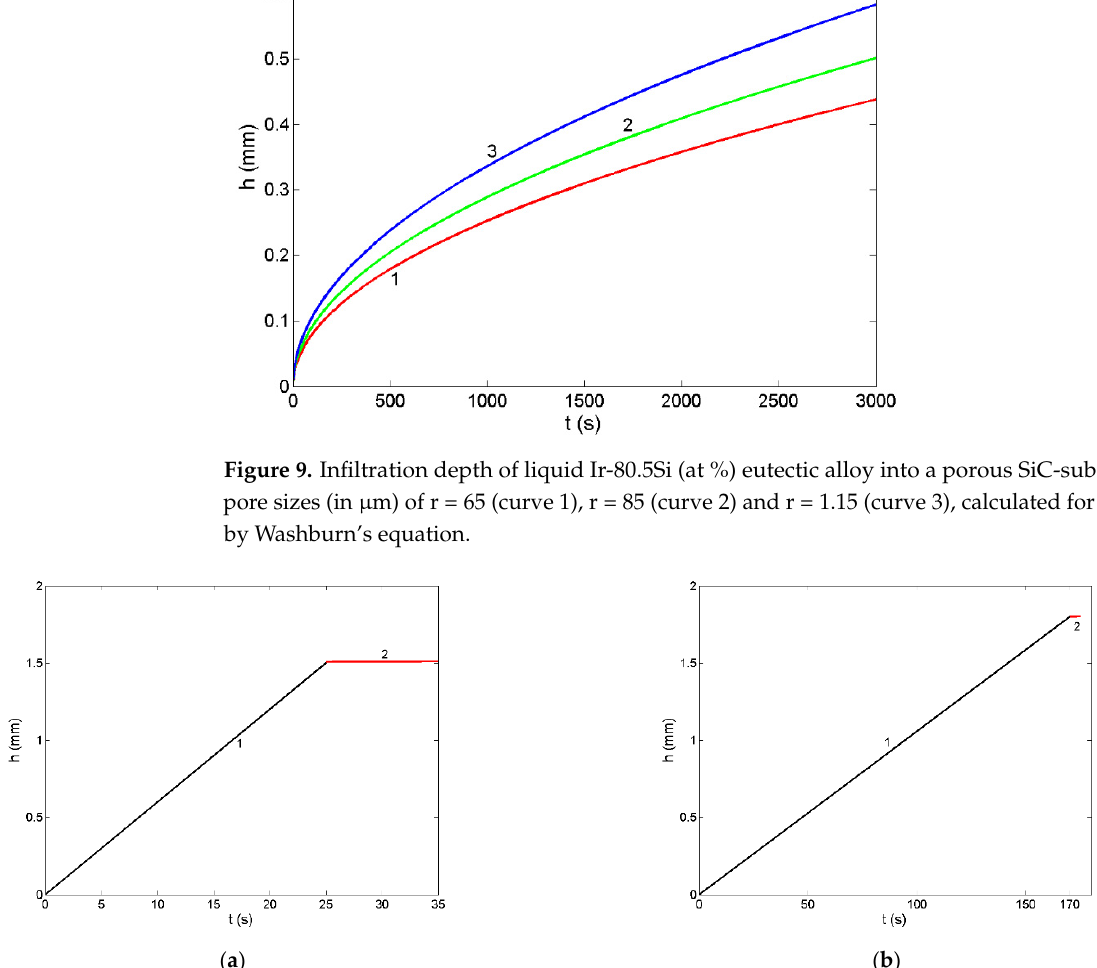
Figure 9. Infiltration depth of liquid Ir-80.5Si (at %) eutectic alloy into a porous SiC-substrate with pore sizes (in μm ) of r = 65 (curve 1), r = 85 (curve 2) and r = 1.15 (curve 3), calculated for T = 1873 K by Washburn’s equation.